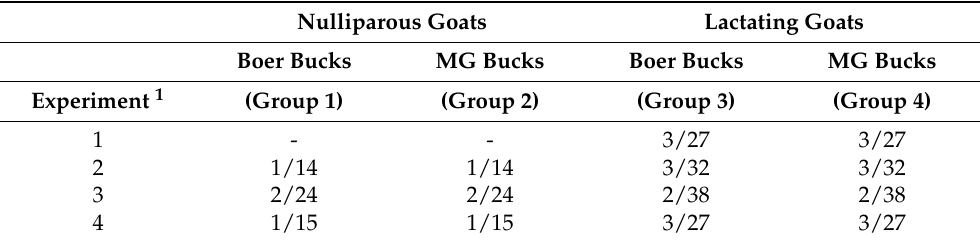
Table 2. Number of bucks/number of goats (nulliparous or lactating) used in each mating group (groups 1 to 4) for each experiment performed to study the terminal crossbreeding of Boer (BO) bucks with Murciano-Granadina (MG)